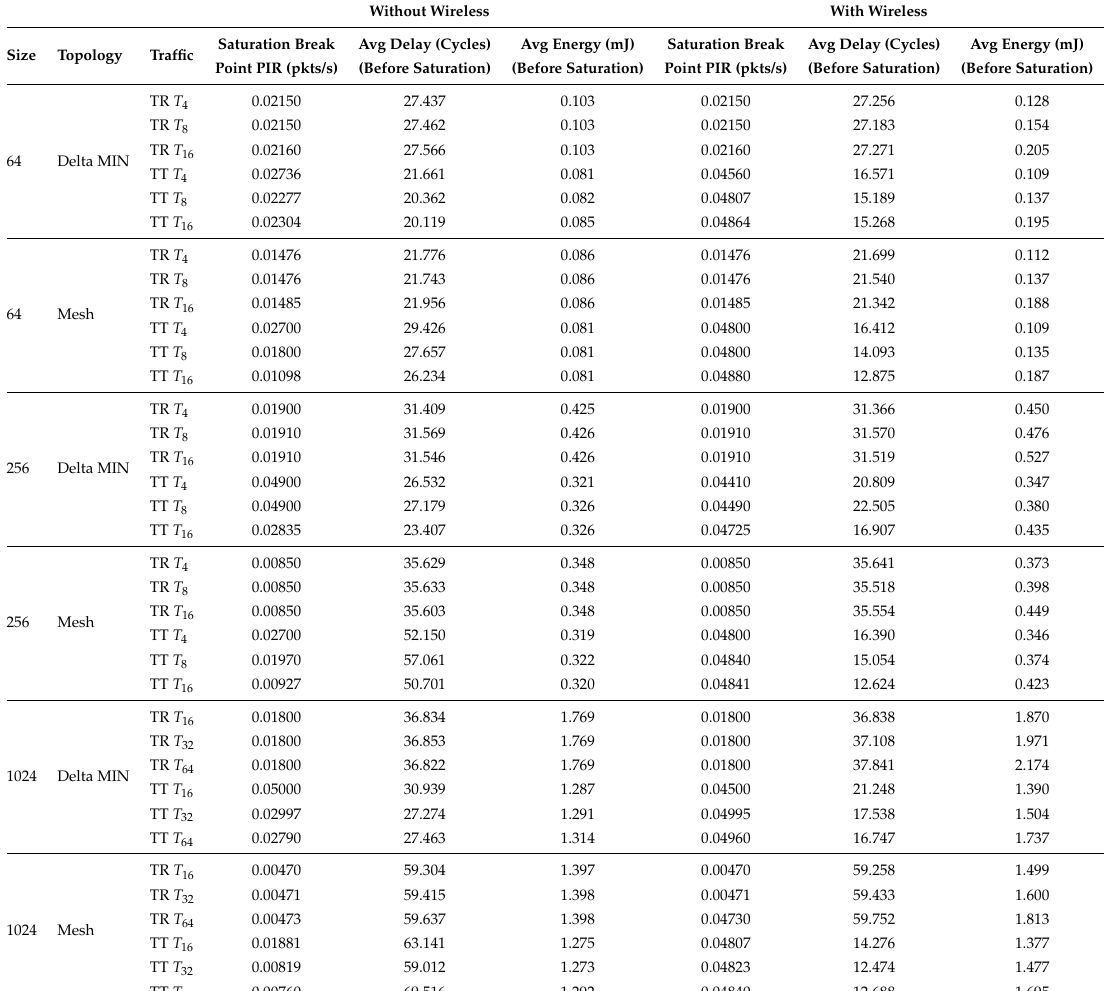
Table 2. Summary of results obtained in the different scenarios presented in Figures 5–16. Without Wireless With